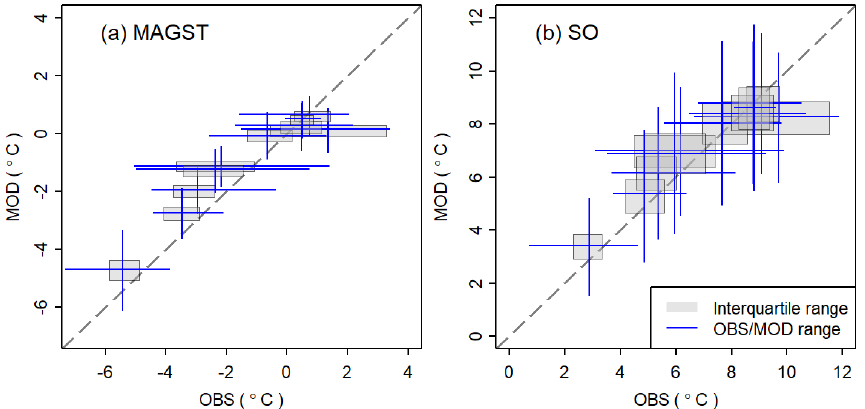
Figure 9. Comparison of ensemble results and observations for (a) mean annual ground-surface temperature (MAGST) and (b) surface offset (SO) for the 10 terrain types.